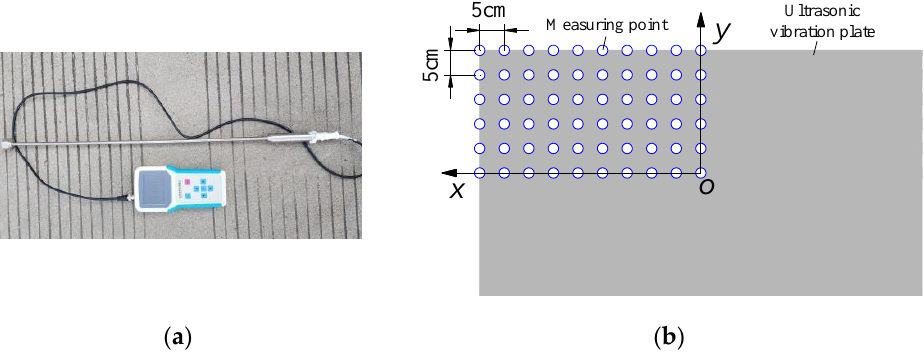
Figure 8. Ultrasonic sound intensity measurement. ( a ) Ultrasonic sound intensity measuring instrument; ( b ) Distribution of sound intensity measurement points.